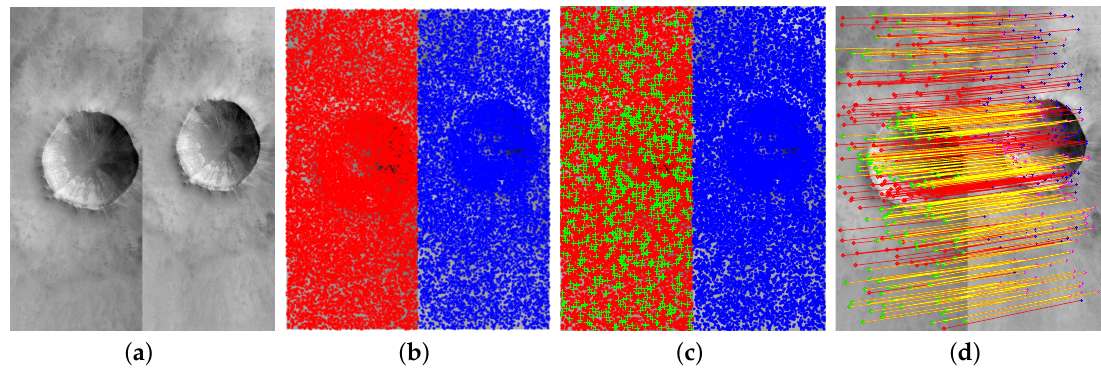
Figure 6. An example of the seed-matching initialization. ( a ) A pair of Martian stereo images captured by HiRISE. ( b ) Features-points extracted by SIFT operator (red and blue stars denote U and U (cid:48) respectively). ( c ) Feature sampling from U (green crosses represent u ). ( d ) False-matches elimination by RANSAC (red cycles, blue crosses and red lines represent the eliminated false-matches; blue cycles, magenta crosses and yellow lines represent the initial